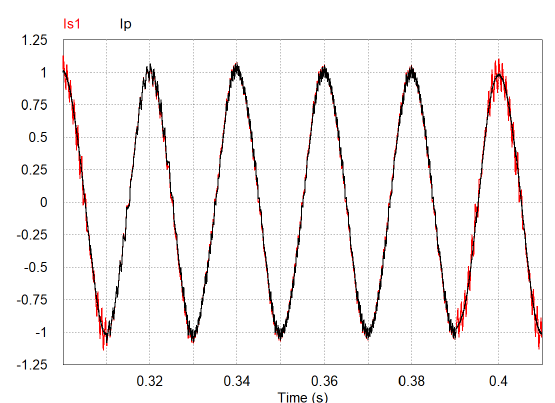
Figure 21. One secondary current and the primary current in normal operation ( t < 0 . 31 s and t > 0 . 39 s), and when a resonance condition is detected. Traces: Is1 - AC current of converter 1, Ip - primary current.